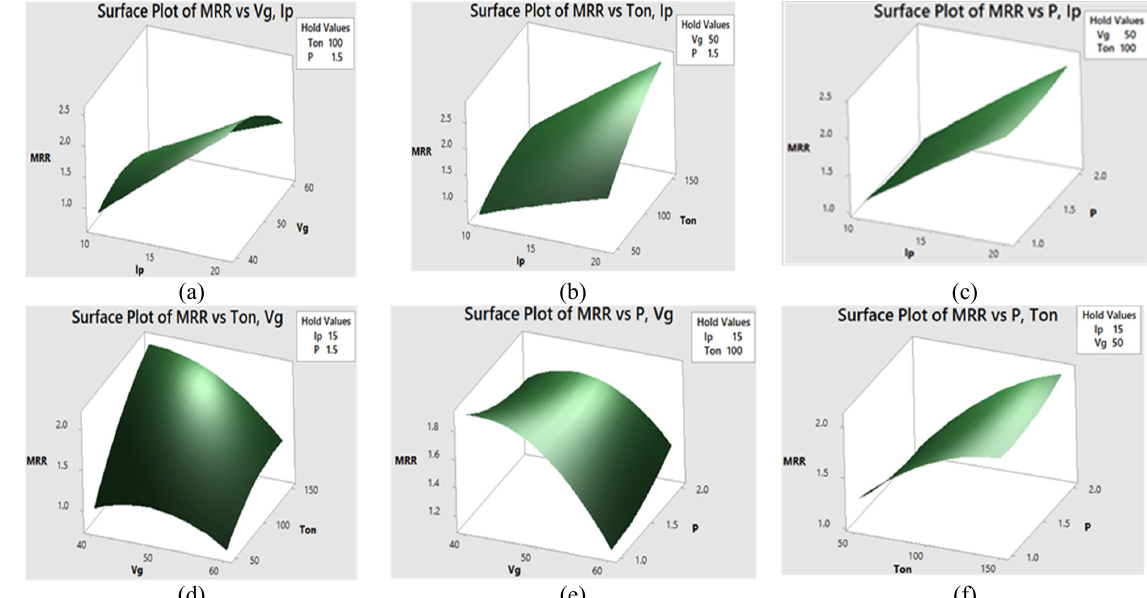
Fig. 5. 3D response surface plots showing (a) the effect of current and voltage(b) the effect of peak current and pulse